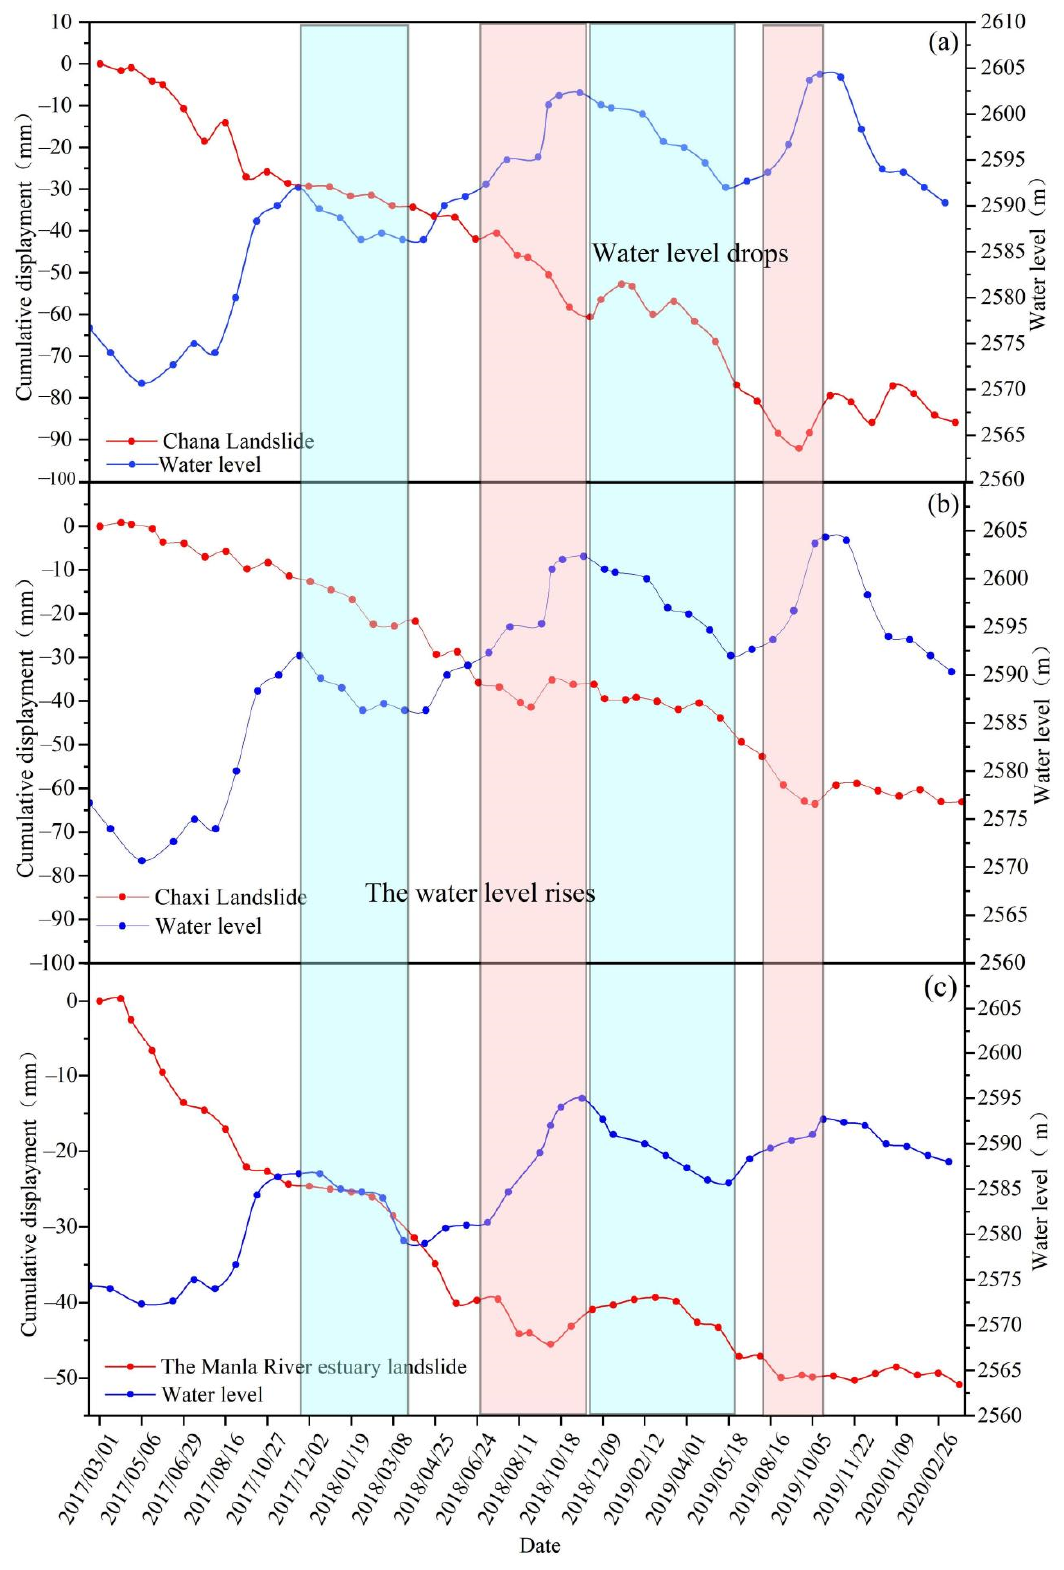
Figure 20. Water level and landslide displacement time series. ( a ) The Chana landslide, ( b ) Chaxi landslide, and ( c ) Mangla River Estuary landslide.